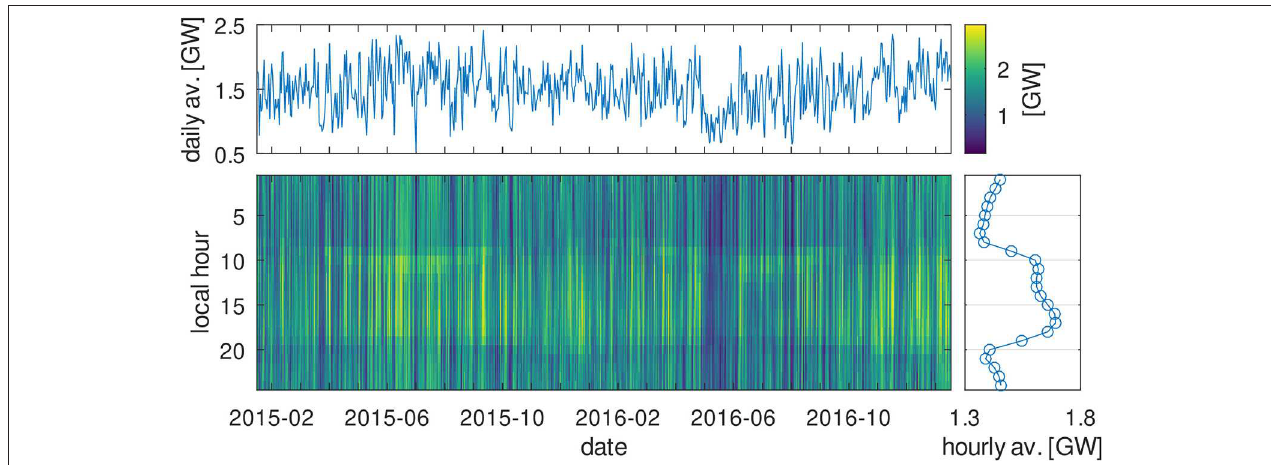
FIGURE 2 | Power series from years 2015 and 2016 of overall 3382.5MW wind and solar facilities, as listed in Tables S2 , S3 . 2458MW correspond to wind facilities while 924.5MW correspond to solar facilities. The overall capacity factor obtained is 47 % , with a coefficient of variation of 29 % . Solar site’s mean capacity factor is 28 % (coefficient of variation 110 % ) and wind site’s mean capacity factor is 54 % (coefficient of variation 37 % ). Current and projected capacity of renewables would have covered 10 % of the overall electricity